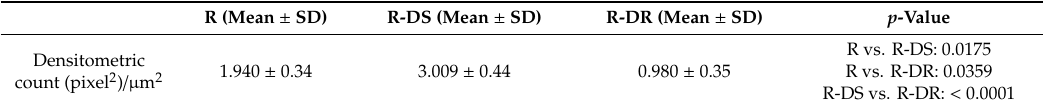
Figure 2. Histochemical evaluation of the mucosubstance content glycosaminoglycan (GAGs) in the articular cartilage by Alcian Blue staining through computerised densitometric measurements and image analysis. ( A ) R group; ( B ) R-DS group; ( C ) R-DR group. In inserts are the image analyses by the software in which the red colour represents Alcian Blue staining, showing a decreased staining in the R-DR group and increased staining in the R-DS group. For details, see the text. ( A – C ) Objective lens, 10; scale bars: 100 μ m. These are the most representative images of articular cartilage from rats of each group (R, R-DS and R-DR).